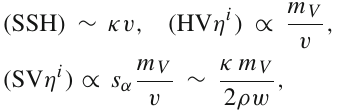
Fig. 2 R SSM as a function of s α , for different values of m S (and the corresponding vev w ). The range of s α is the one deduced from Table 3. R SSM VV is computed with q γ = q max